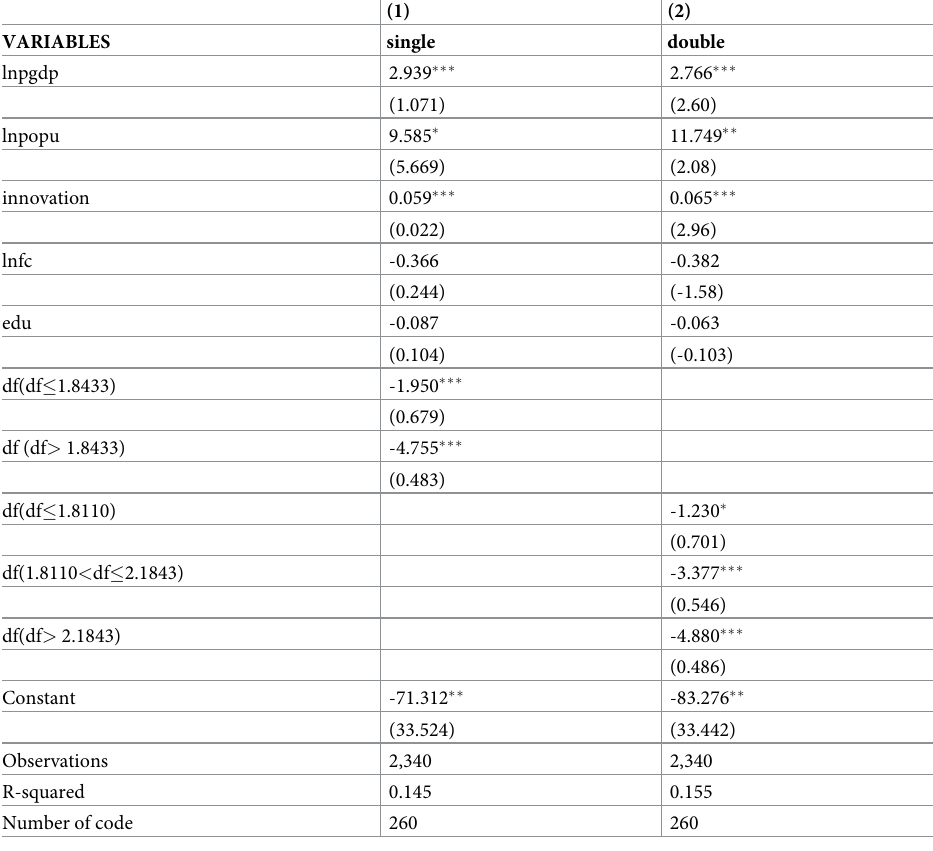
Table 9. Double threshold effects regression